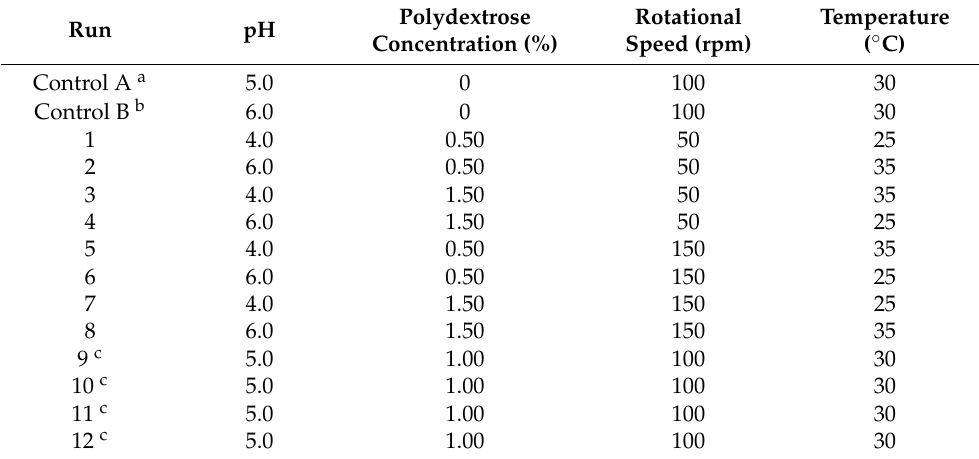
Table 1. 2 4-1 Plackett-Burnman factorial design used to investigate the influence of pH, polydextrose concentration, rotational speed and temperature on P. pentosaceus ATCC 43200